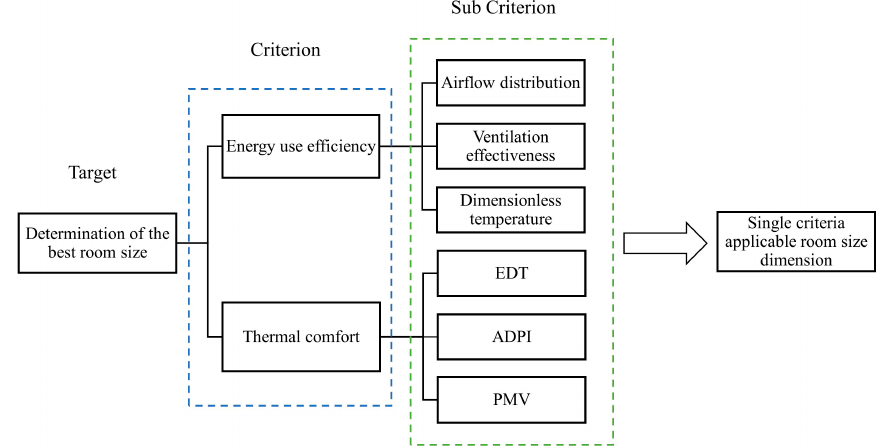
Figure 4. Hierarchical model for the evaluation of suitable room size.